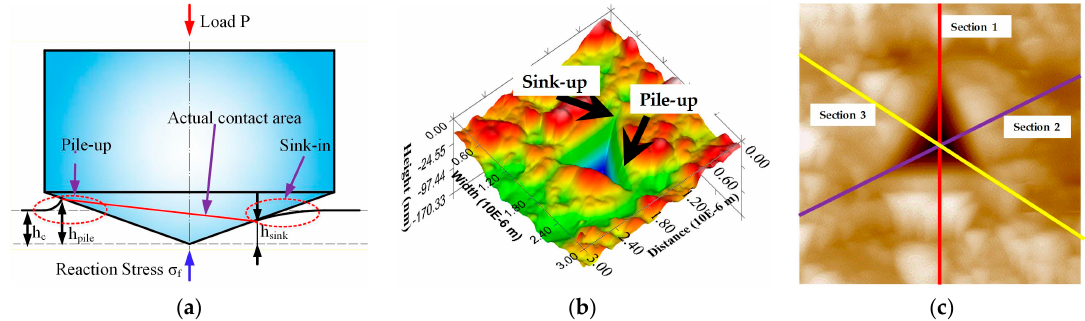
Figure 11. ( a ) Pile-up and sink-in behaviors during nanoindentation tests; ( b ) a 3D probe scanning of a 3 µ m × 3 µ m patch of the indentation surface corresponding to Figure 10k; ( c ) the three characteristic cross sections across the center point.